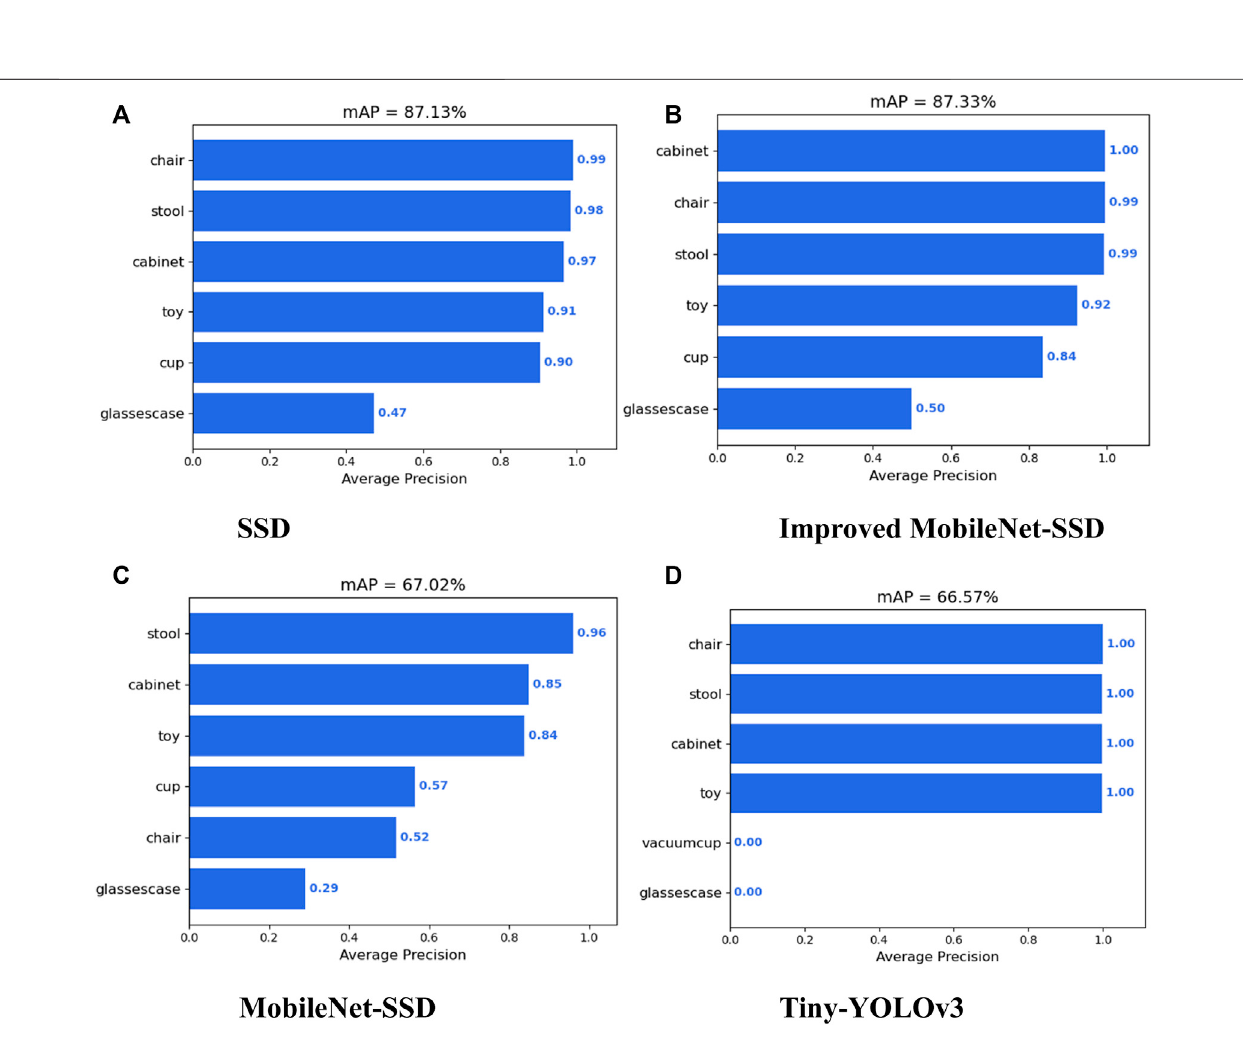
Frontiers in Bioengineering and Biotechnology |